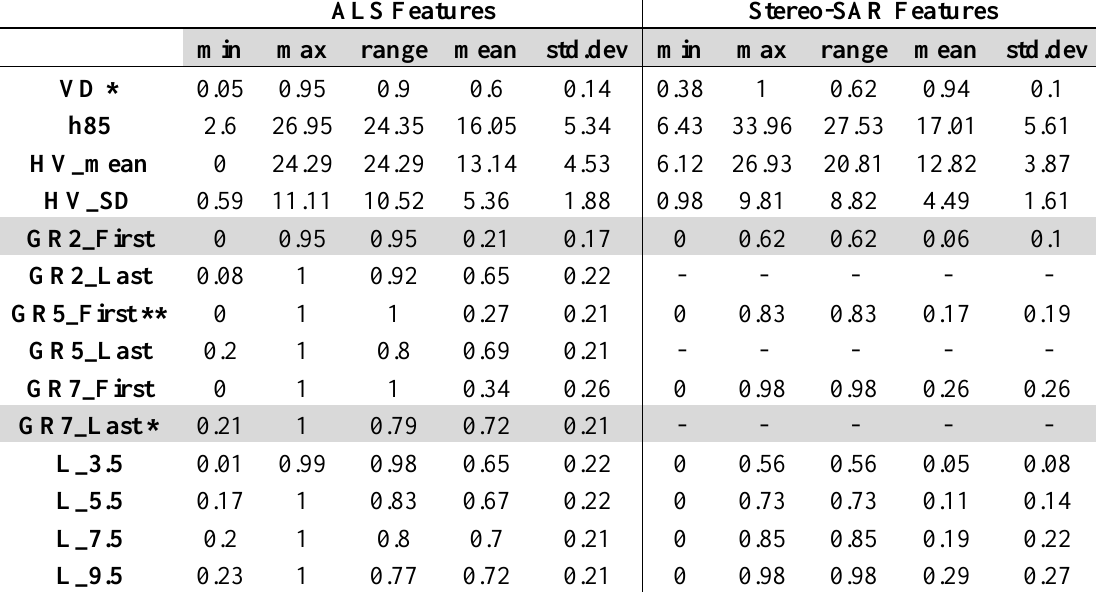
Table A1. ALS- and SAR-derived features, and minimum, maximum, range, mean and standard deviation of the values. The abbreviations are explained in Table A2. The ALS and stereo-SAR features used in the predictions are marked with * and **,